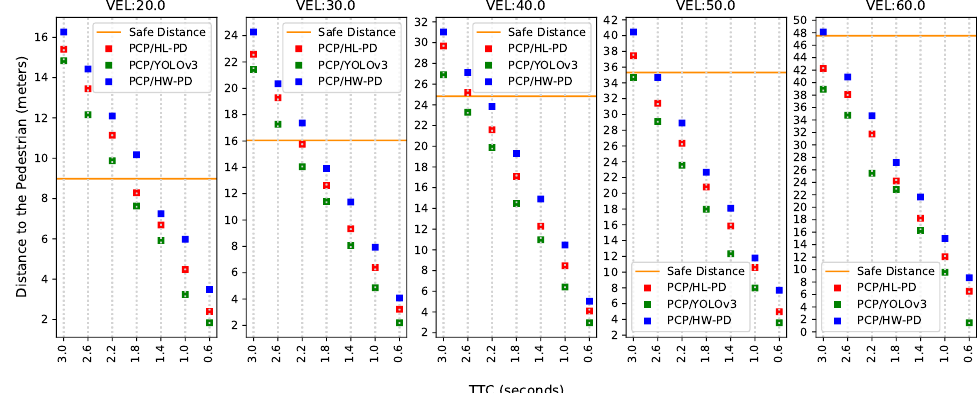
Figure 16. First collision prediction since the pedestrian’s emergence. The comparison was made involving our PCP system (PCP/HW-PD), PCP system with OpenCV-based detector (PCP/HL-PD) and PCP system with YOLOv3-based detector (PCP/YOLOv3).